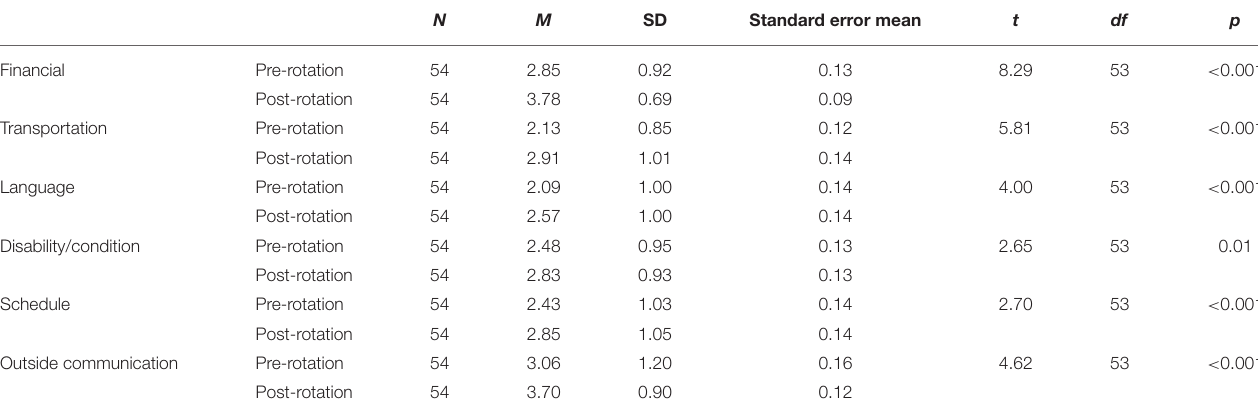
TABLE 2 | Student confidence in managing barriers to care before and after participating in a service-learning community medicine rotation.